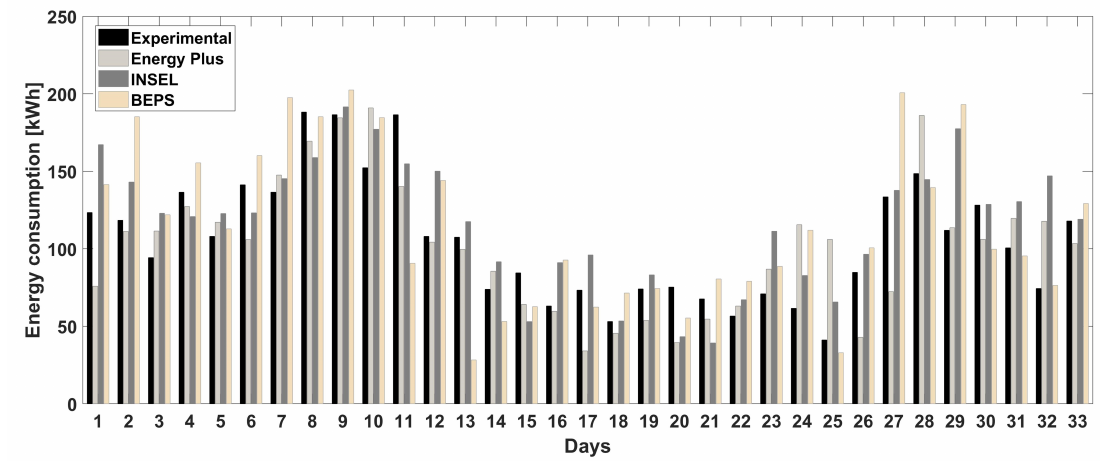
Figure 9. Comparison between experimental and numerical (E+, INSEL and BEPS) daily building heat demand profiles in the considered